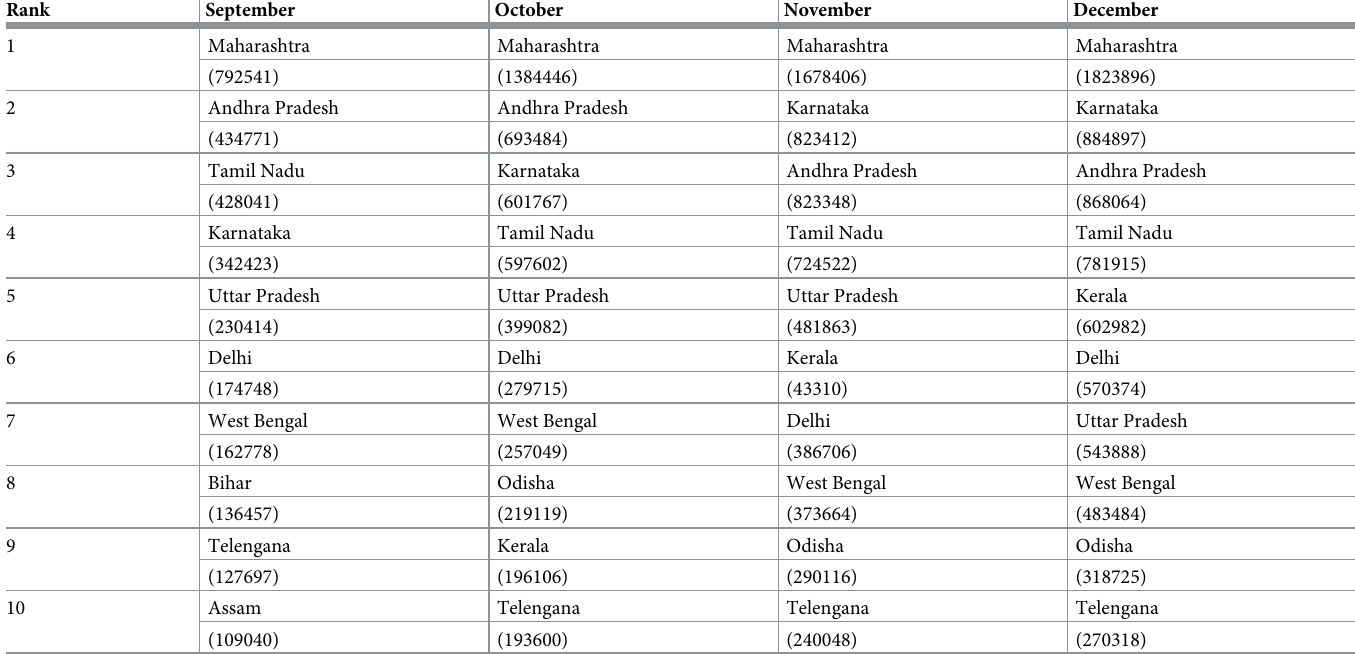
Table 2. Rank of states by number of novel total cases taken at the 1st of every month for September to December 2020 [15]. The number of novel cases are shown in brackets. Rank